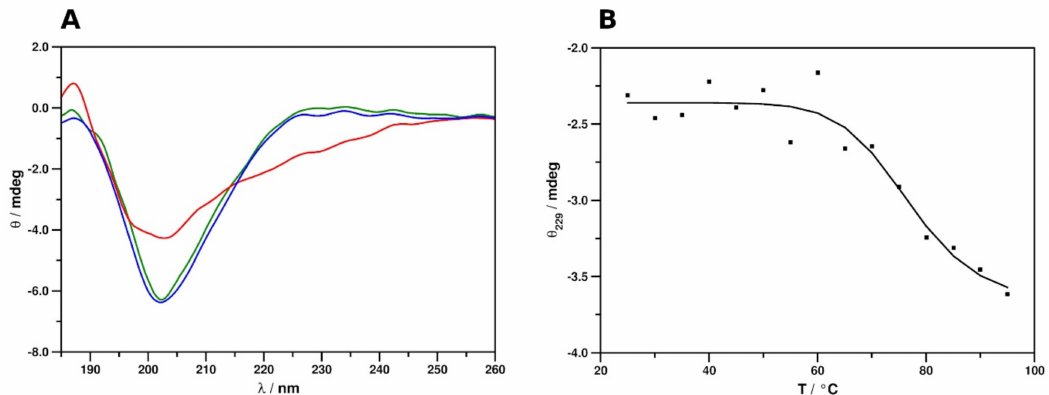
Figure 6. ECD spectra and thermal unfolding curve of PAFC. ( A ) Spectra in the 185–260 nm region were measured at 25 ◦ C (green), 95 ◦ C (red), and again 25 ◦ C (blue) after refolding. ( B ) Thermal unfolding of PAFC, followed by ECD spectra at 229 nm. T m = 77 ◦ C.